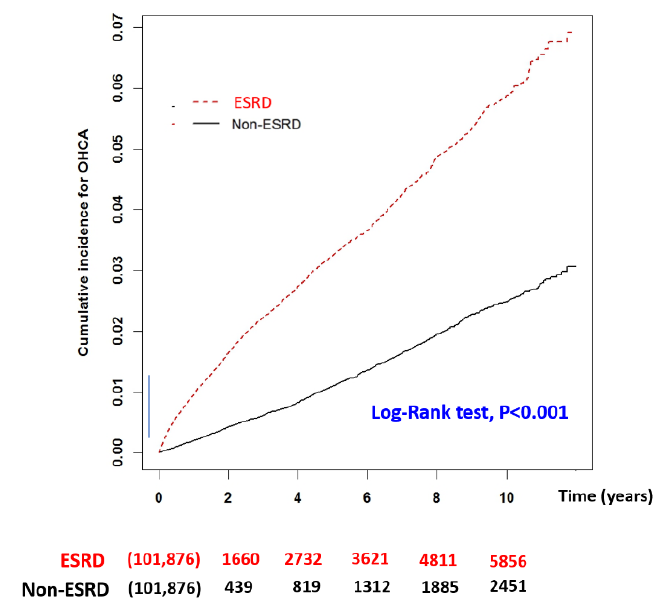
Figure 2. Kaplan-Meier with log-rank test to measure the cumulative incidence of OHCA between the matched ESRD in regular dialysis and non-ESRD patients. X -axis displays the time in years. Y -axis displays the cumulative incidence of OHCA. p < 0.05 is the threshold for significance. ESRD: End-stage-renal-disease; OHCA: out-of-hospital cardiac arrest.